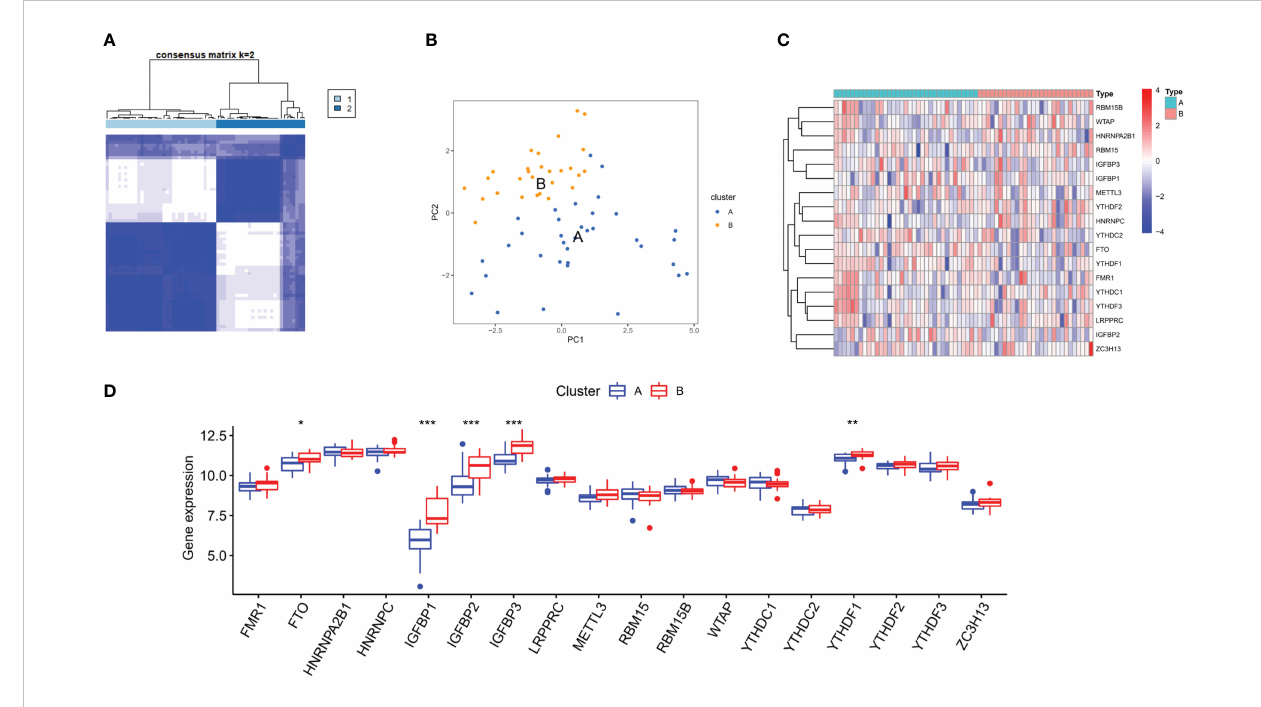
FIGURE 6 Distinct m6A RNA methylation modi fi cation pattern of OA. (A) Two different m6A subtypes of OA by the unsupervised consensus cluster analysis. (B) Principal component analysis of the transcriptome pro fi les indicated the two subtypes were signi fi cantly different. (C, D) Heatmap and box plot of 18 m6A regulators expression between the two m6A modi fi cation subtypes of OA. *p < 0.05, **p < 0.01, and ***p <